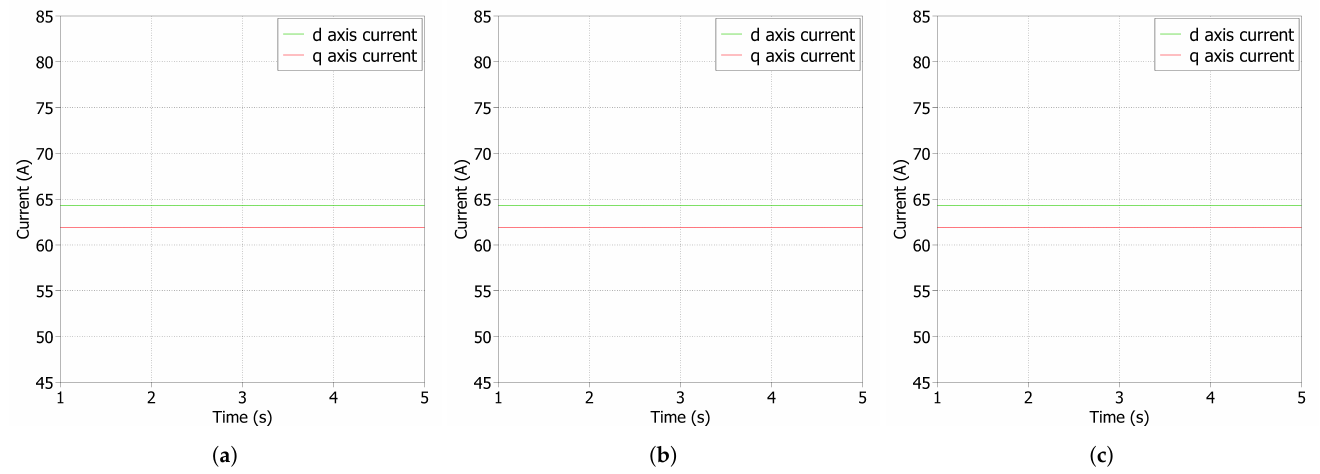
Figure 19. Time domain simulations of the VSC inductor current I L for different AVC filter cases. The step change in PLL’s proportional gain at t = 1.5 s from K P , PLL 0 = 0.1637 to K P , PLL = 1.637 has no stability impact in the strong grid case (SCR = 10); ( a ) f AVC,LPF = 20 Hz;( b ) f AVC,LPF = 50 Hz; ( c ) f AVC,LPF = 100 Hz.